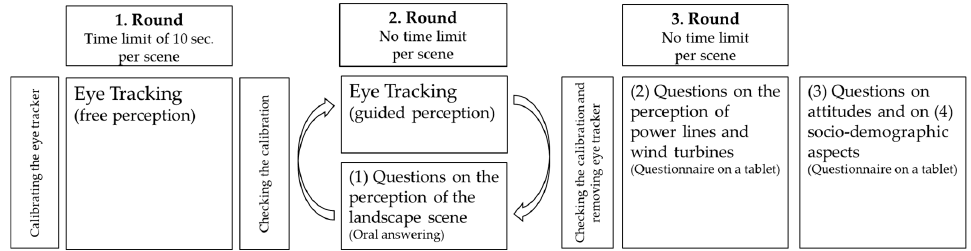
Figure 3. Steps of the overall procedure of the experiment.